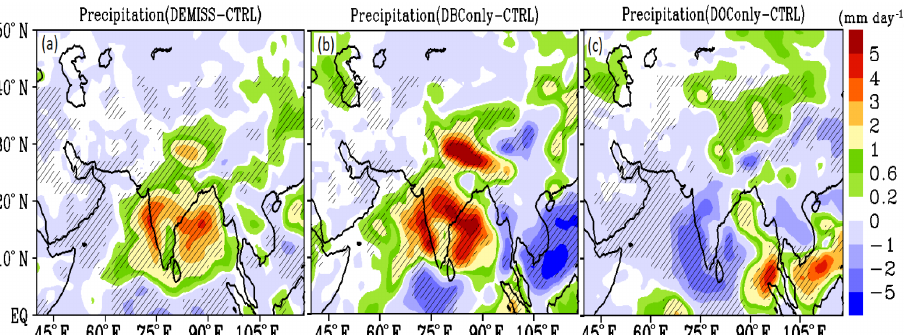
Figure 7. Distribution of anomalies in precipitation (mmday − 1 ) averaged for the monsoon season obtained from (a) Demiss-CTRL, (b) DBConly-CTRL and (c) DOConly-CTRL. Black hatched lines indicate the 99% confidence